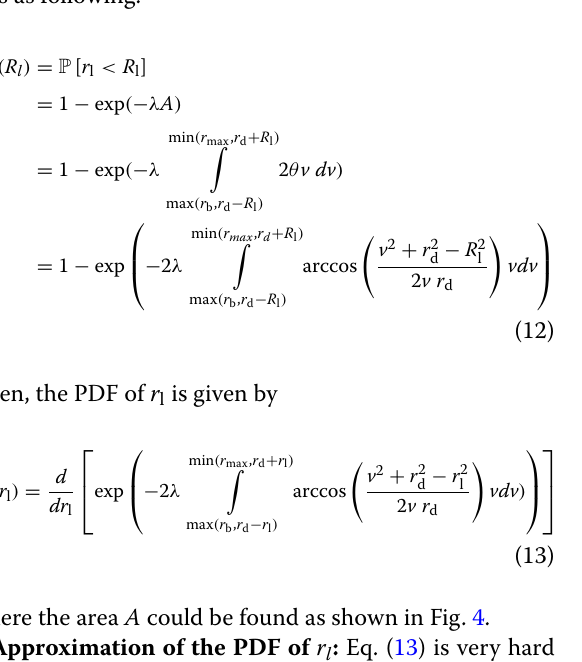
plementary Cumulative Distribution Function (CCDF) of r l is as